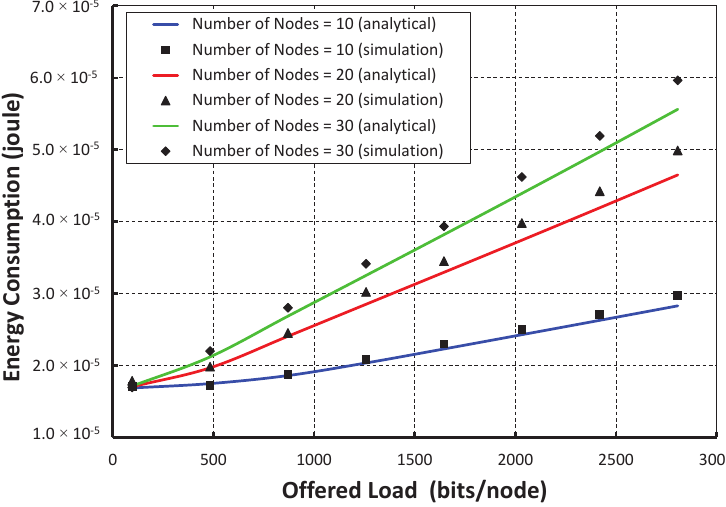
Figure 10. Validation of energy consumption for different offered